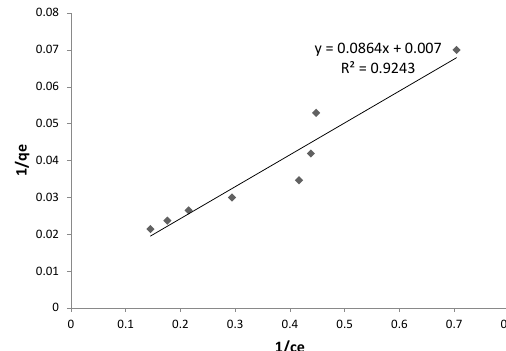
y = 0.0864x + 0.007 R² = 0.9243